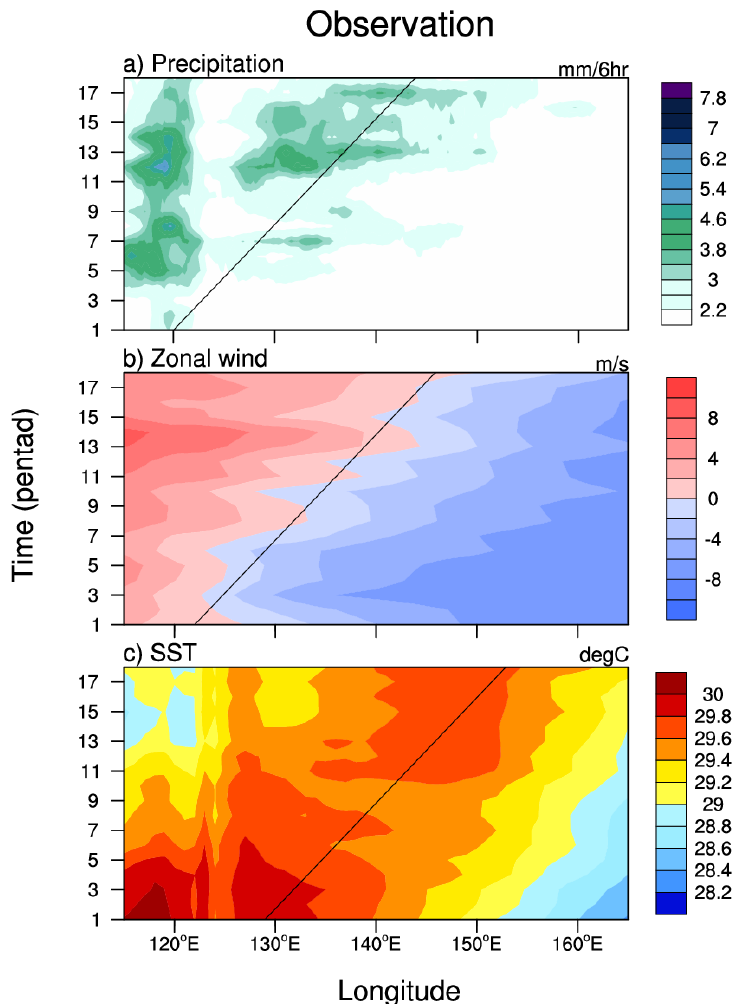
Figure 1. Hovmoller diagrams of climatological pentad mean ( a ) precipitation (unit: mm/6 h), ( b ) zonal wind (unit: ms − 1 ) at 850 hPa, and ( c ) SST (unit: ◦ C), averaged over 10 ◦ N–15 ◦ N, based on observational data. The Y-axis unit is pentad (every 5 days, from June 1 to August 31). Data are derived from TRMM and ERA-interim for a 20-year period ( 1998 – 2017) .